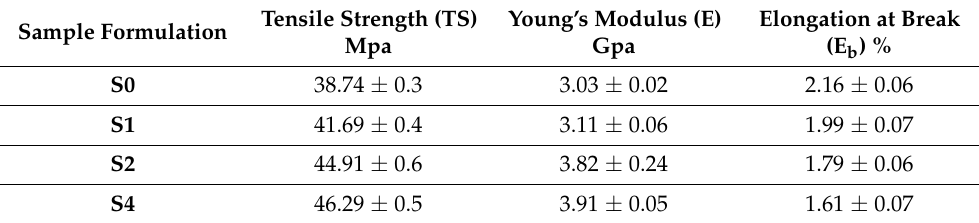
Table 3. Mechanical properties of pristine PS and PS/m-sepiolite nanocomposites. Sample